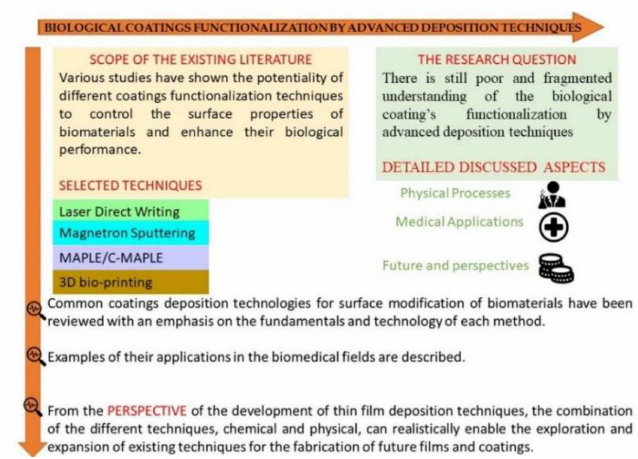
Figure 2. Manuscript